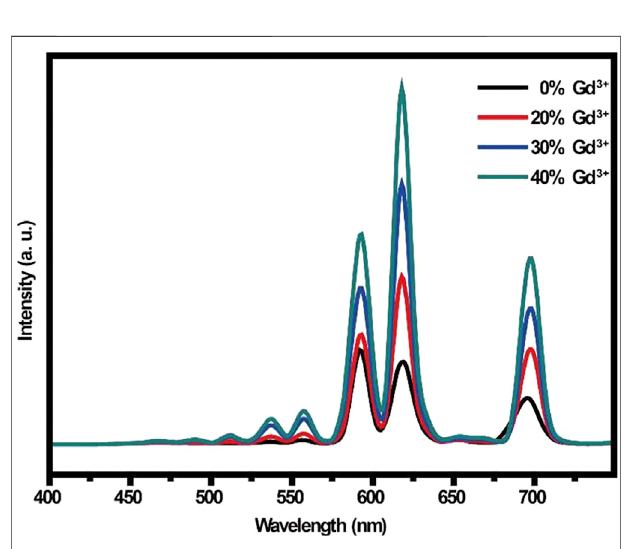
FIGURE 4 | Emission spectra of β -NaLaF4:Eu 3+ , Gd 3+ red nanomaterials with different Gd 3+ -doping concentration (Nie et al., 2017).